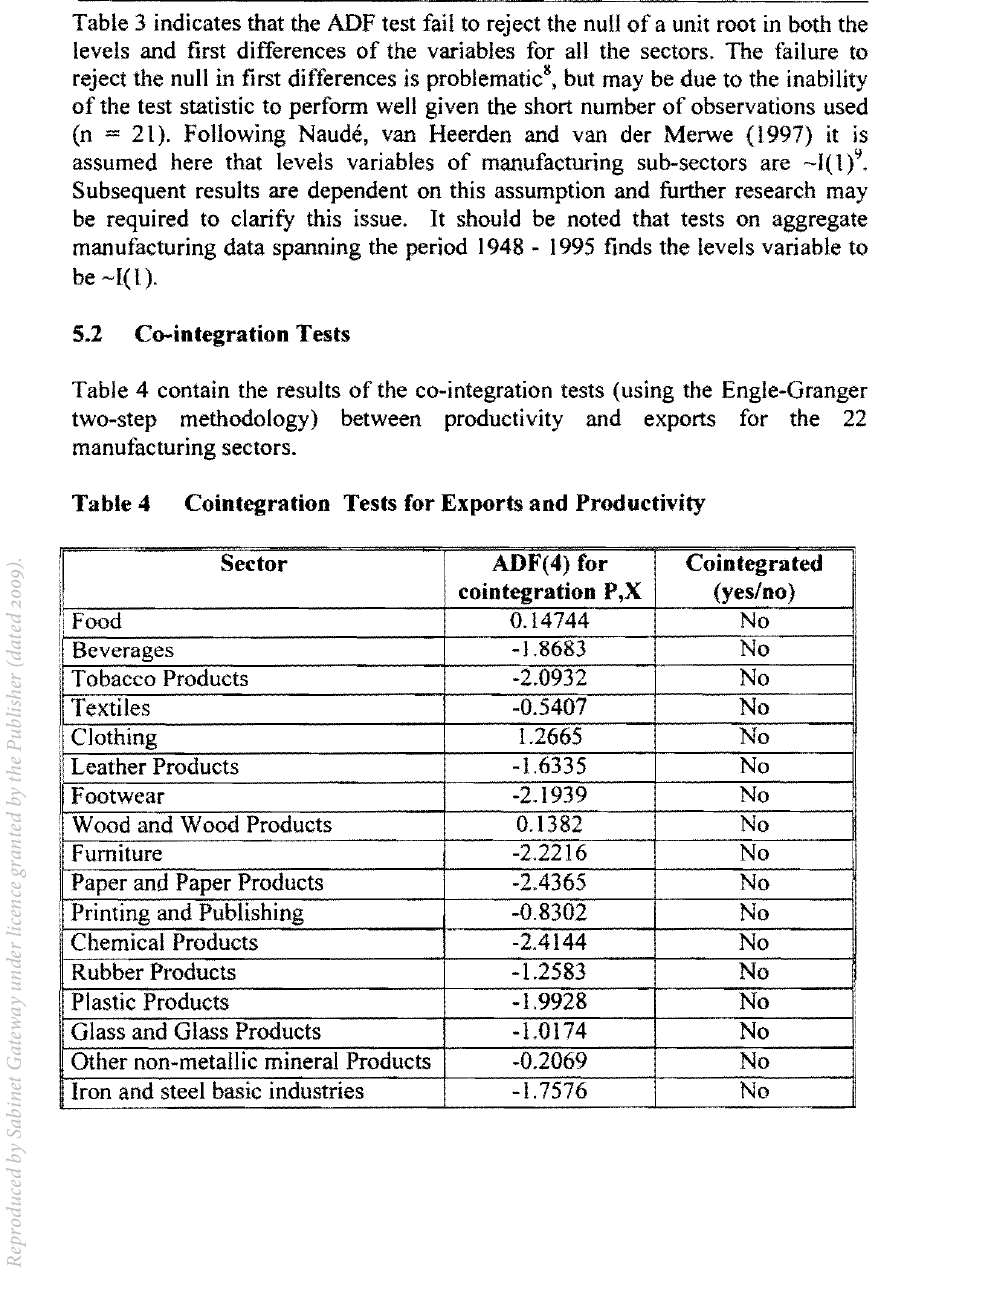
Cointegration Tests for Exports and